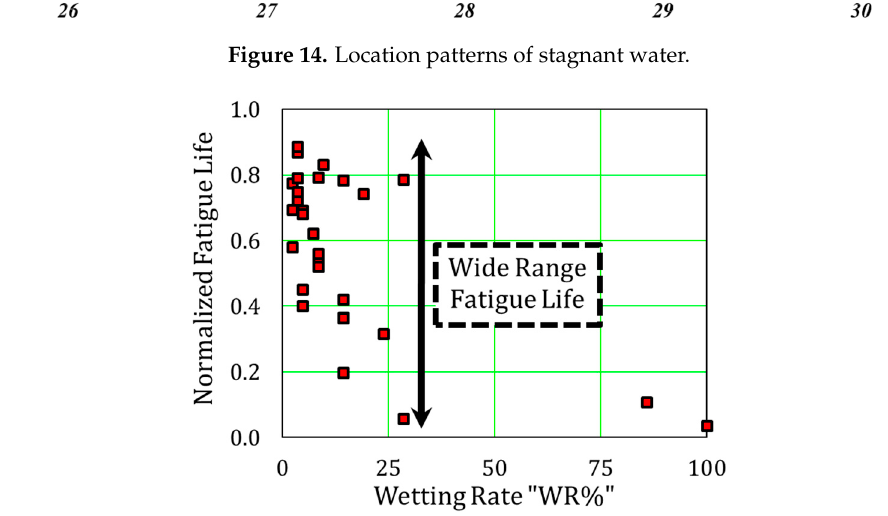
Figure 15. Relation of wetting rate at the top layer of RC deck and the fatigue life.